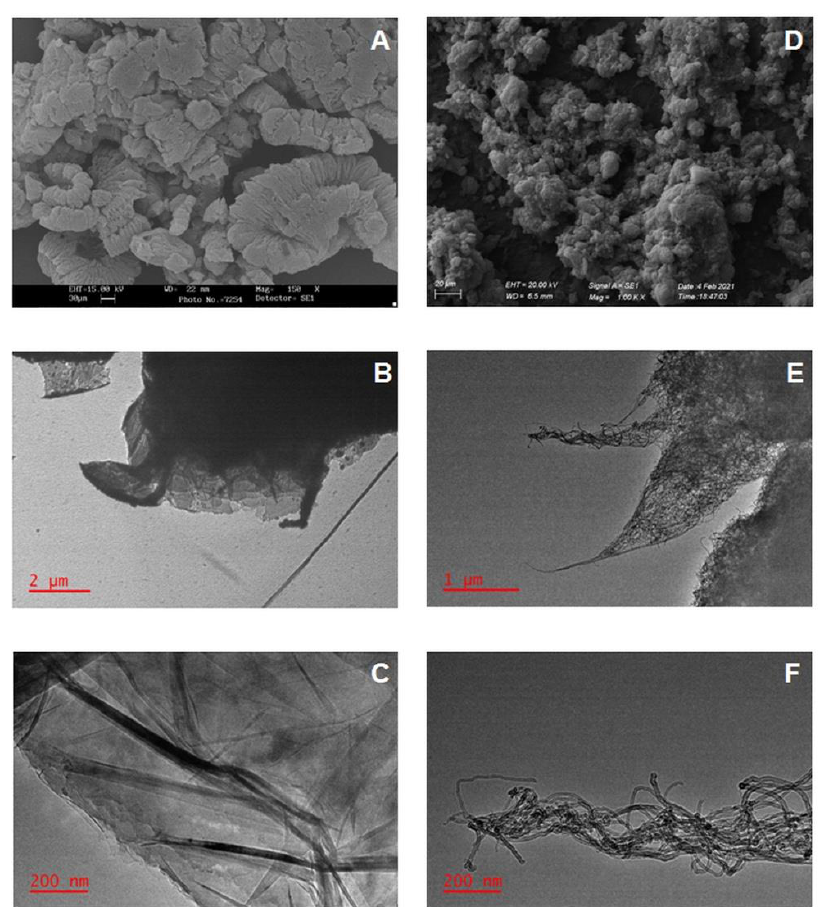
Figure 1. Scanning electron microscope (SEM) images of HRCM ( A ) and MWCNT ( D ) agglomerates at different magnifications. EHT = voltage acceleration (kV); WD = working distance, the distance between the sample surface and the final lens of the microscope; MAG = magnification, where X corresponds to the magnification; SE1 indicates that the images were collected with the secondary electron detector. Images ( A ) and ( D ) were taken by two different SEMs (see Section 2.2) but with the same criteria so as to be comparable. Transmission electron microscopic (TEM) images of HRCM ( B , C ) and MWCNTs ( E , F ) after 3 h of ultrasonication. Photographs were taken using an FEI Tecnai 200 TEM, operating at 200 kV working with a field emission electron gun.